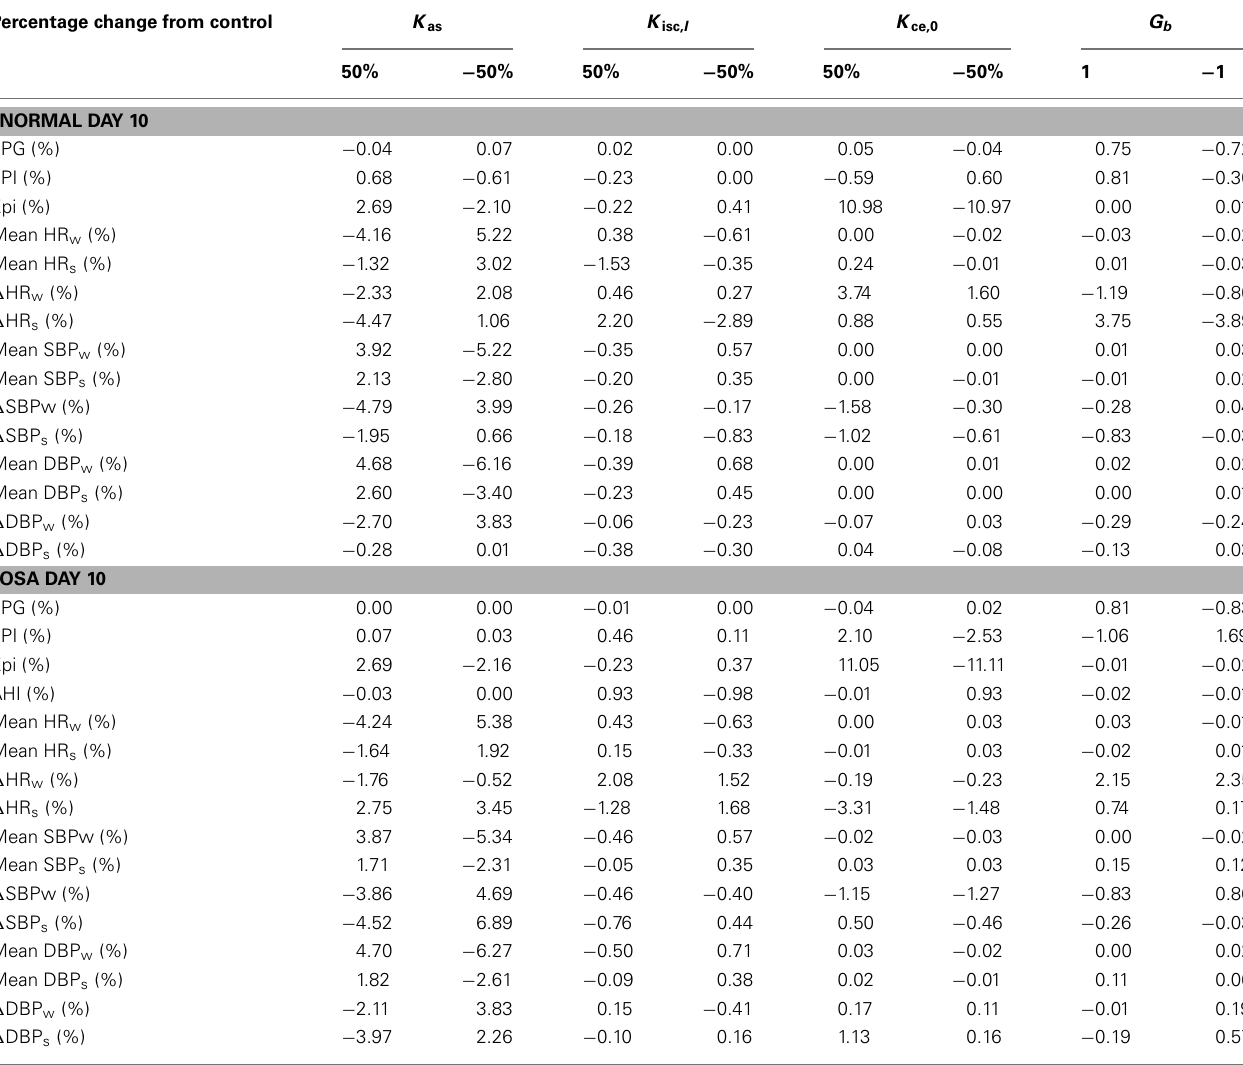
Table 2 | Sensitivity analysis of key parameters in metabolic model that contribute to autonomic and metabolic interactions. Percentage change from